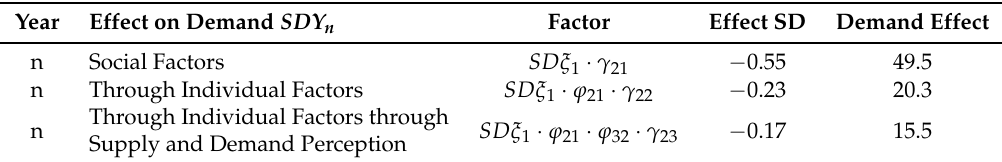
Table 6. The effects on